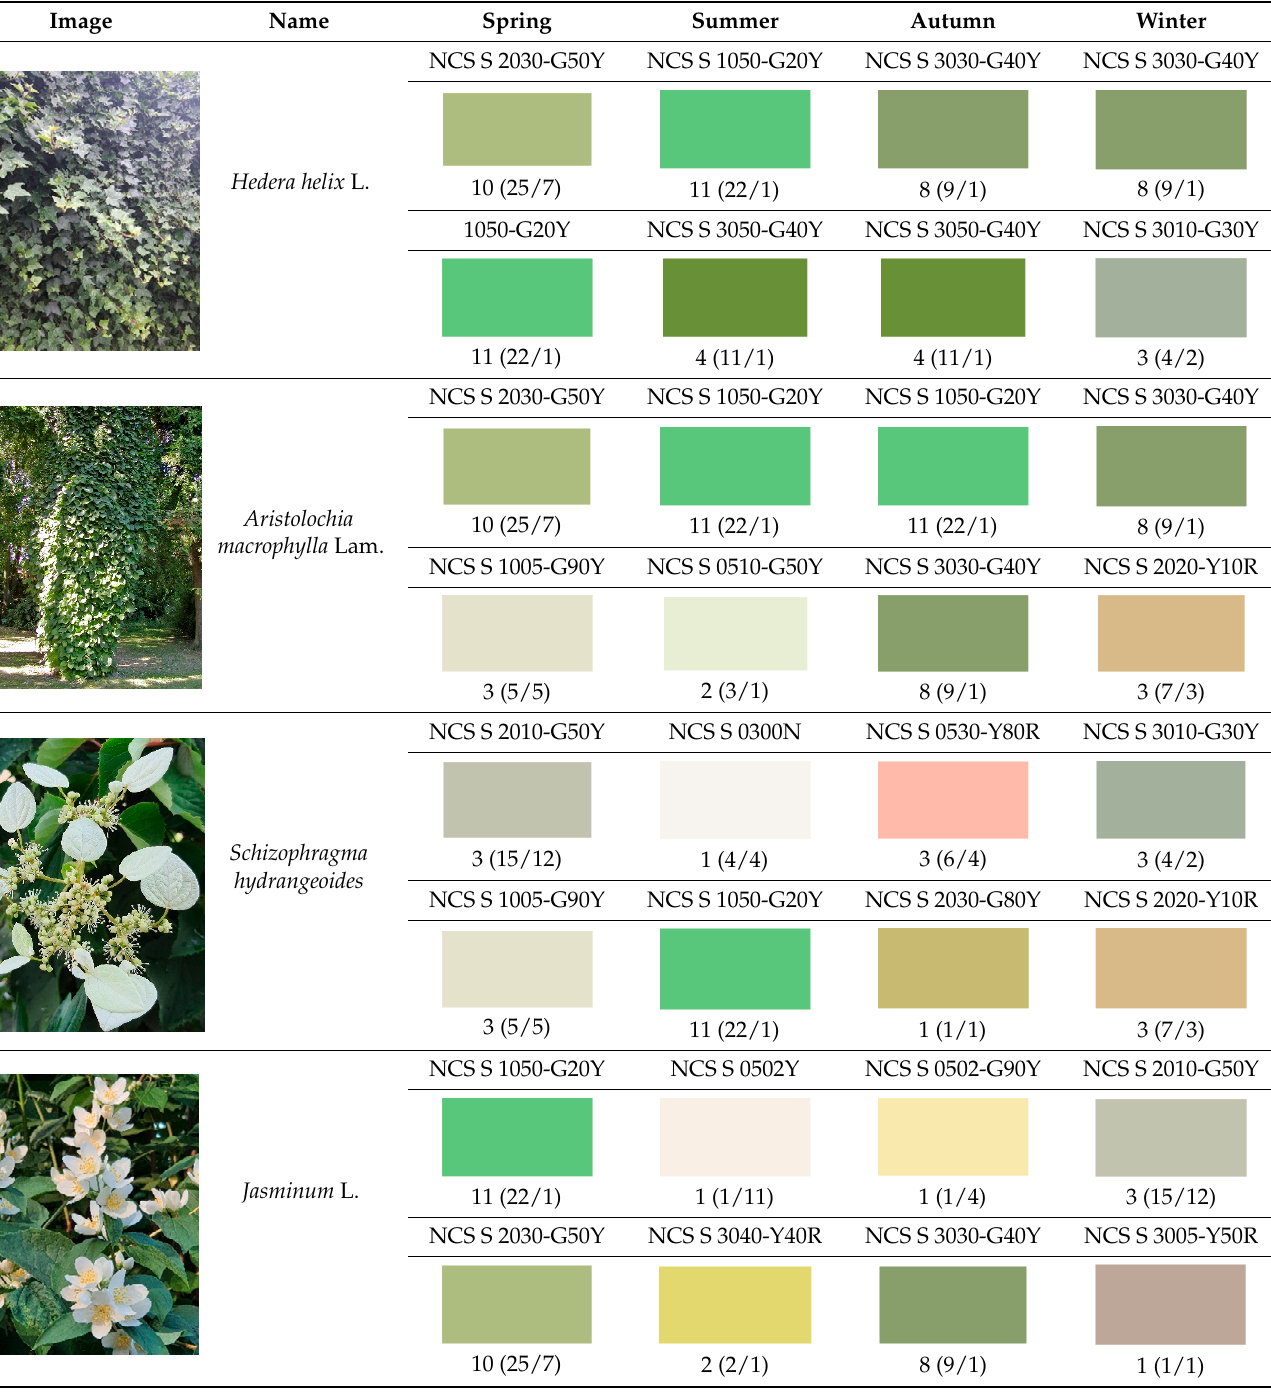
Table A2. Ninety-six color samples taken from shrubs and creepers identified in the research area. The numbers below the color sample provide the information how many times a given color appears in the table (how many times it appears in all natural samples/how many times it appears in the analyzed architectural